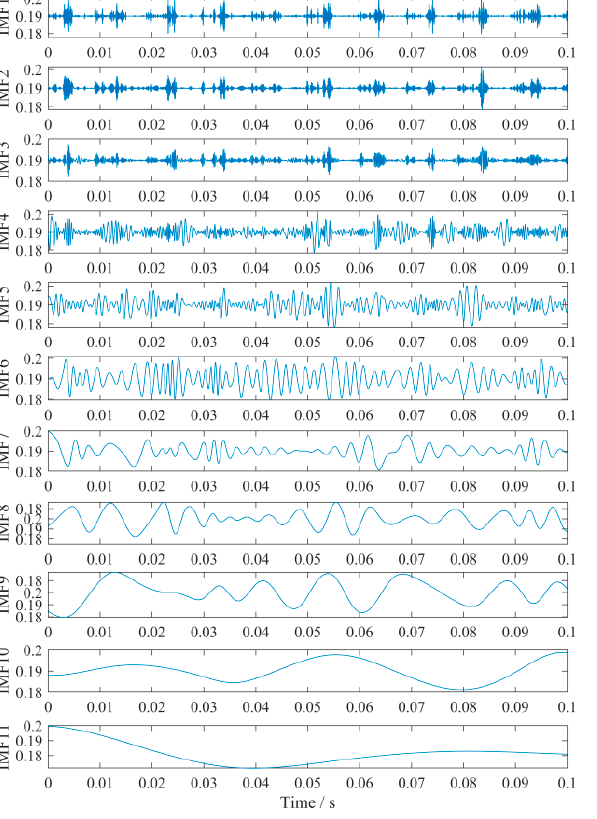
Table 2. The correlation coefficient of the IMF component. IMF Components